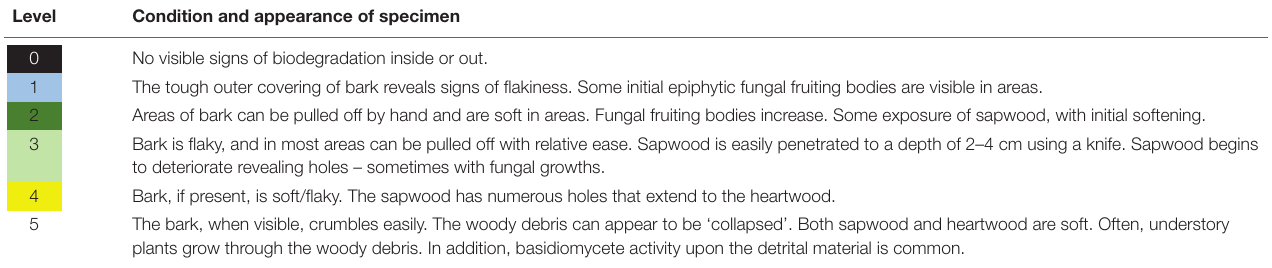
FIGURE 1 | Biodegradation boundaries of large woody debris (LWD) within mangroves sites at Kaledupa Island, Indonesia. The three layers represent shore height elevation, the type of biodegradation process found on LWD and the type of terrain in each site. Each mangrove forest has been color-coded by the type of biodegradation process within that forest (terrestrial = green, marine = blue) and the height above mean sea level, elevation (meters mean ± SE) of each forest is also highlighted. The boundary between the terrestrial and marine biodegradation is indicated by the yellow line within the Galua and Laulua forests. TABLE 1 | Scale describing levels of fungal wood decay observed in large woody debris (LWD) in the Sombano and Langira mangrove forests. Note, level colors correspond to Figure 2A